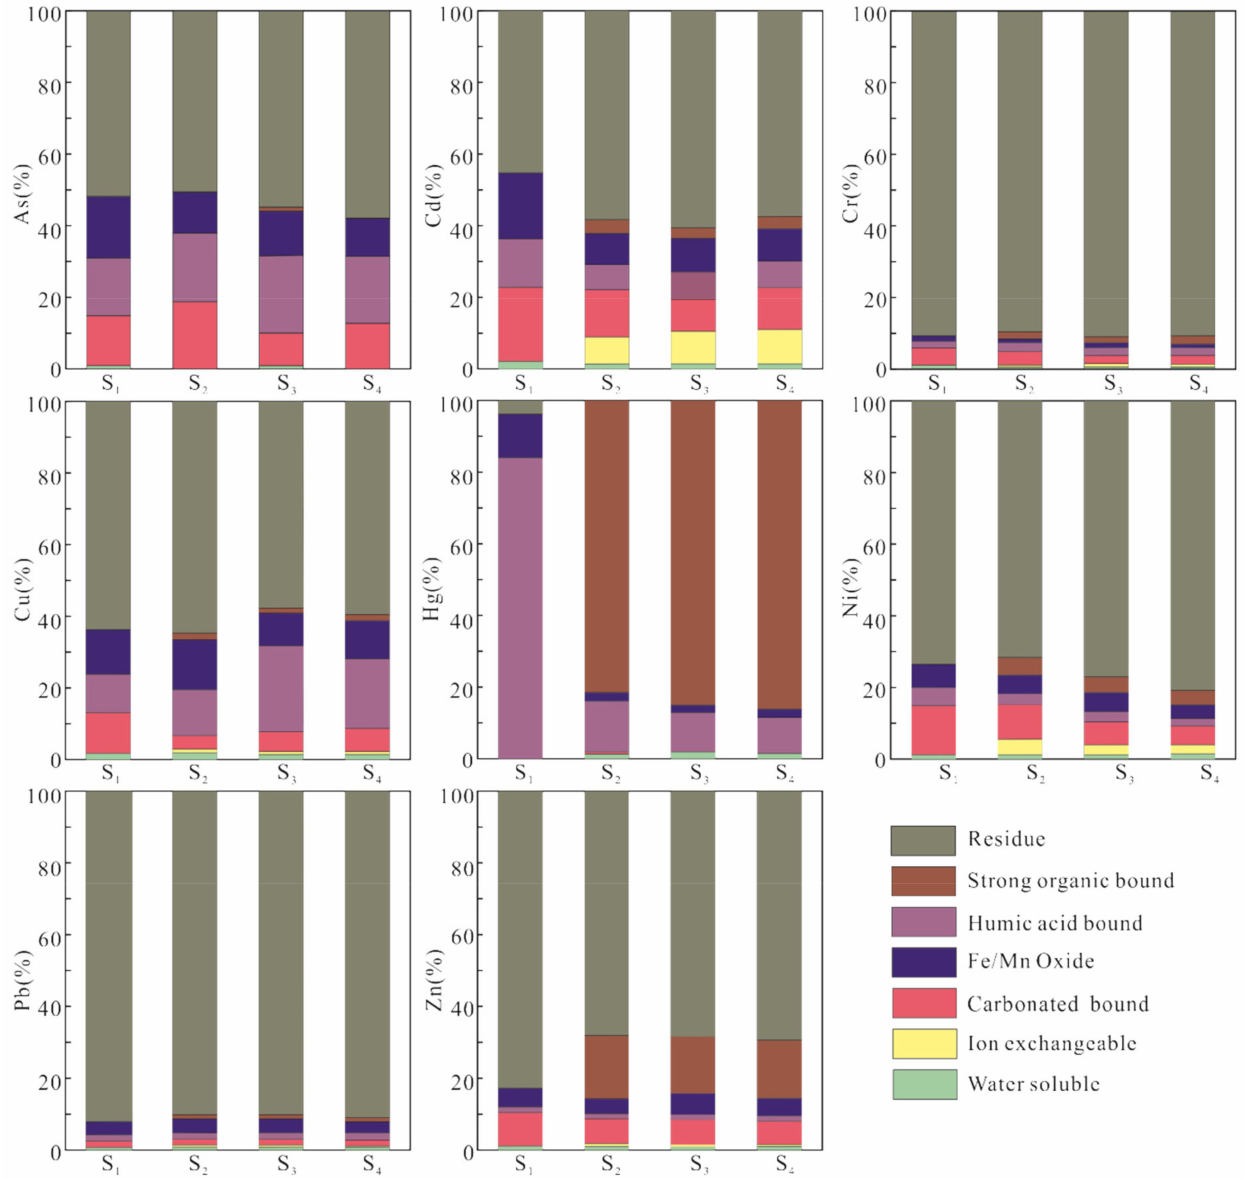
Figure 5. Speciation of heavy metals in surface soils from four sites of the study